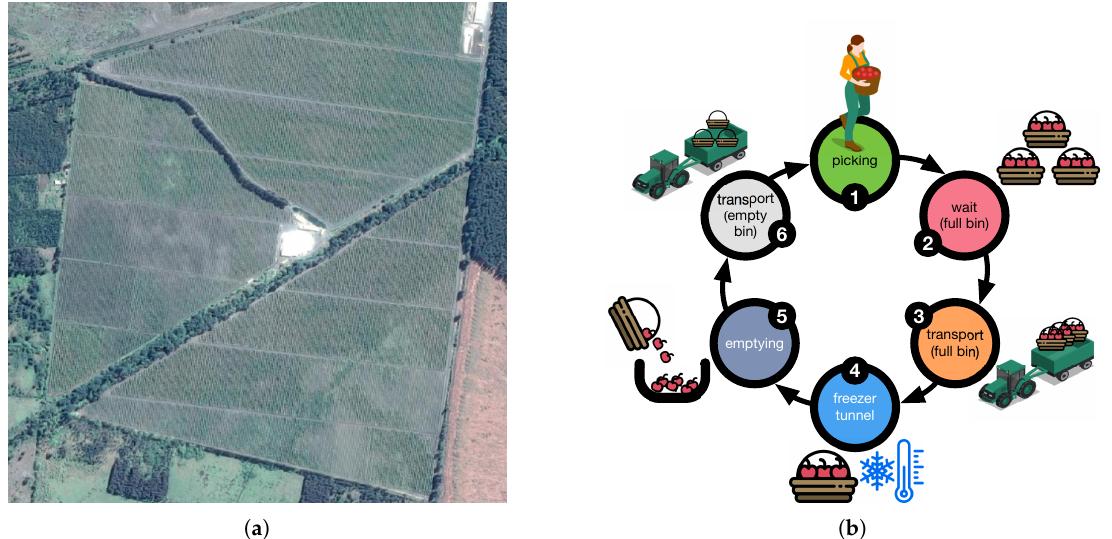
Figure 2. ( a ) Aerial view of the blueberry site owned by El Boldo, located in the municipality of Yungay in Chile’s VIII Region (Lat: − 37.1149584, Long: − 72.1973101), and ( b ) the six processing stages of a basket in blueberry harvesting at El Boldo.